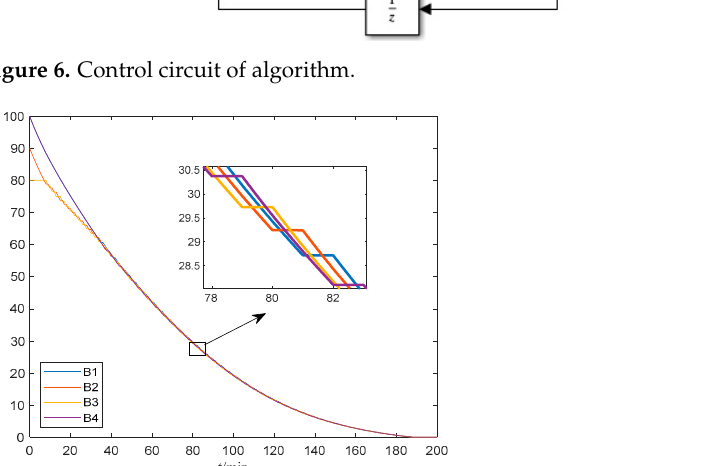
Figure 7. Dynamic redundant ba tt ery management algorithm working process diagram.